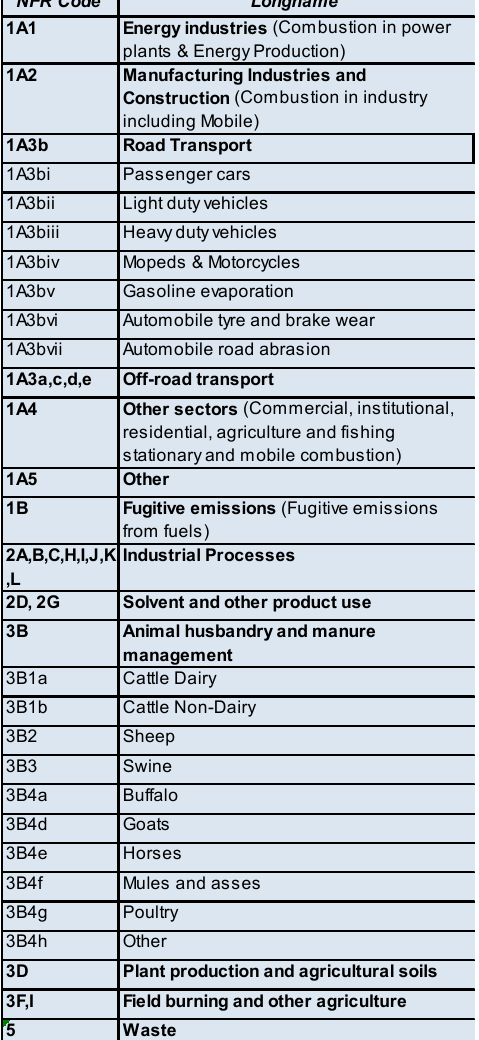
Figure A4. NFR source categories (nomenclature for reporting (NFR)).